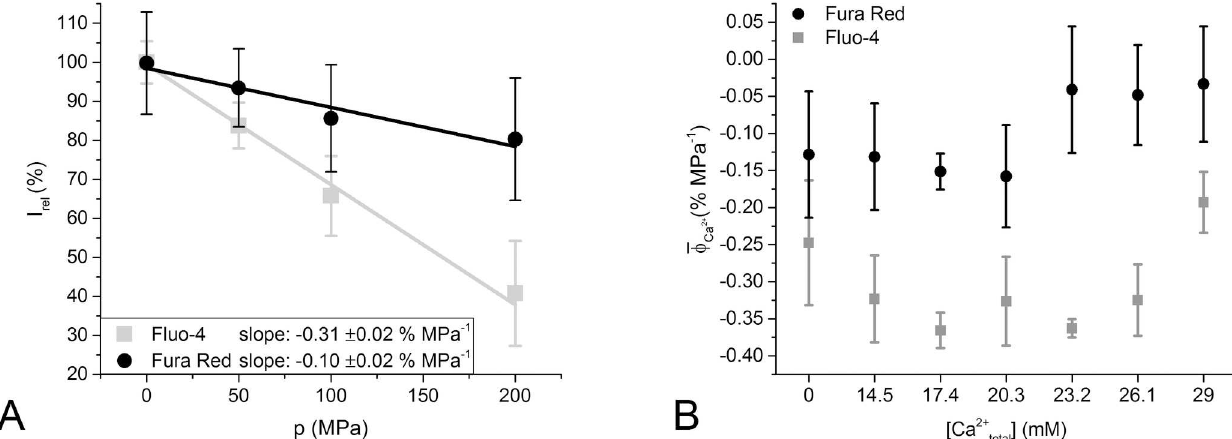
Fig 6. Pressure-dependence of dye fluorescence at different total Ca 2+ concentrations. A: Mean of relative fluorescenceintensity I rel of all data sets of Fluo-4 and Fura Red, plotted against hydrostatic pressure p. The number of observations n for each averaged data point is between 22 and 44, and the standard deviationof the data is displayedas error bars. A linear fit was appliedto the averaged data points, the slope of which represents the overall averagerelative fluorescence change (cid:22) (cid:30) , determined as − 0.308% MPa -1 for Fluo-4 and − 0.100% MPa -1 for Fura Red. B: Mean relative fluorescence change over pressure (cid:22) (cid:30) of the data sets separated by total calcium concentration for Fluo-4 and Fura Ca 2 þ Red. The number of observations n is 3 to 4 for each box and dye.